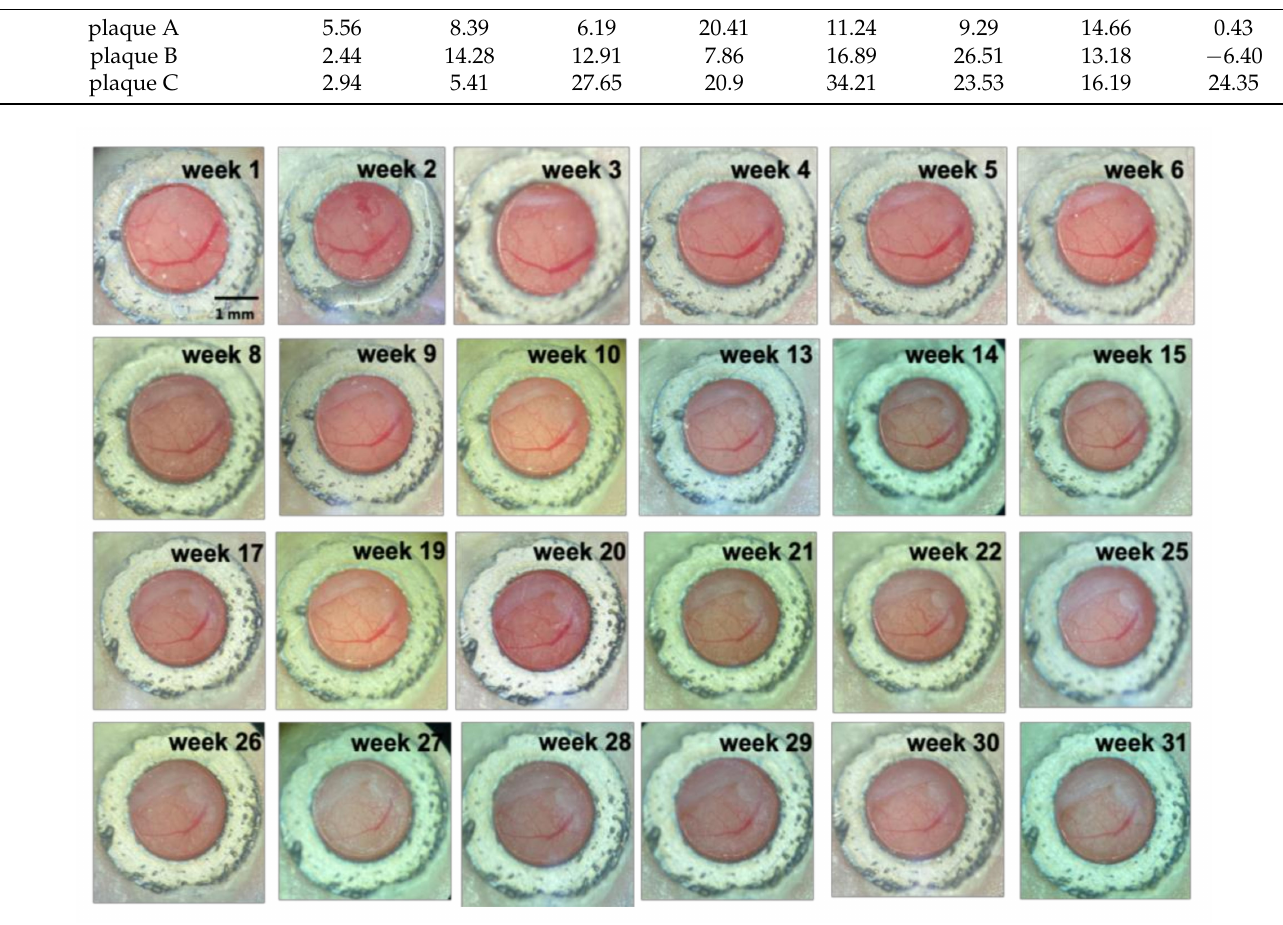
Figure 4. Visualization of cranial window over time. Scale bar: 1